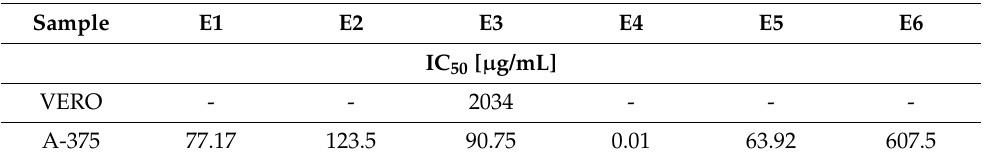
Figure 4. Inhibition of proliferation of A-375 and Vero cells by extracts E1 ( A ), E2 ( B ), E3 ( C ), E4 ( D ), E5 ( E ), and E6 ( F ), measured by MTT. Values are expressed as a percentage of the control regarded as 100%; * p < 0.01, ** p < 0.005, one-way Anova, Dunnett’s test. Table 2. IC 50 values of extracts E1-E6. The IC 50 on the Vero line could not be determined for E1, E2, E4, E5 and E6, as their cell viability was